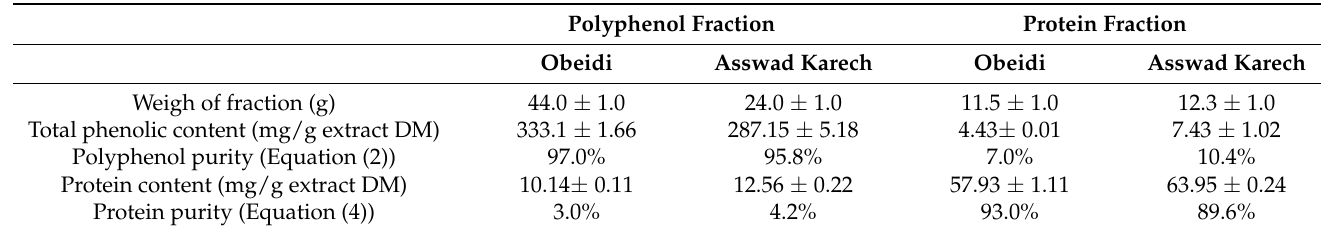
Table 2. Amount and purity of polyphenol and protein fractions from Obeidi and Asswad Karech seeds. Polyphenol Fraction Protein Fraction Obeidi Asswad Karech Obeidi Asswad